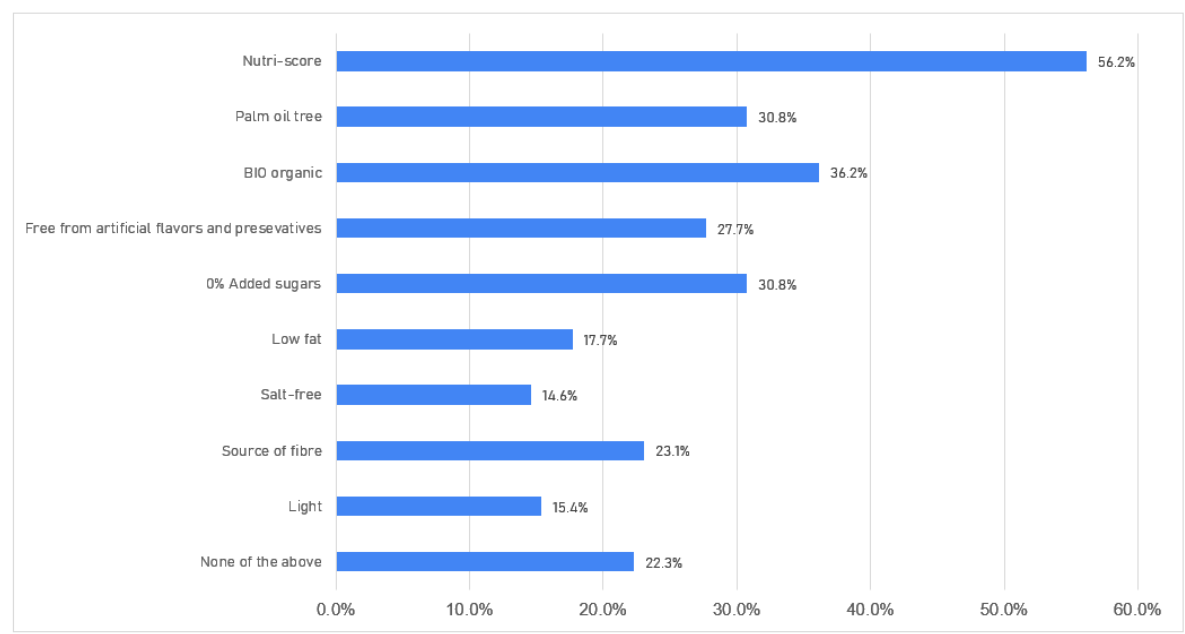
Figure 2. Nutritional claims and additional nutritional information.